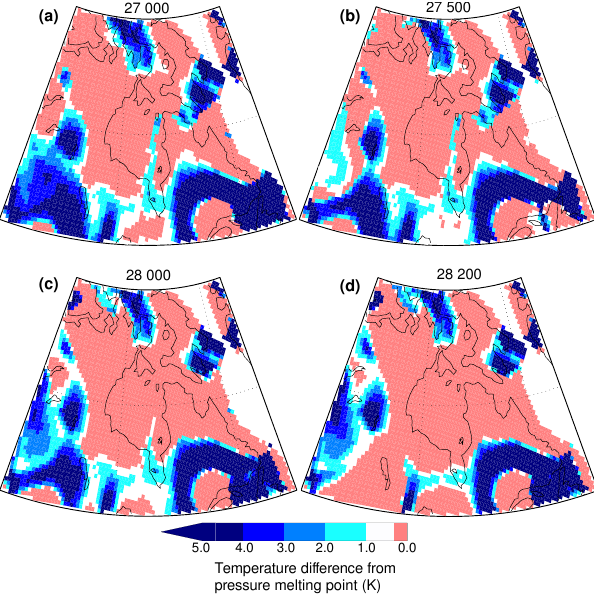
Figure 4. Time slices of the basal temperature field taken at (a) 27000 years, (b) 27500 years, (c) 28000 years and (d) 28200 years. The times shown are the same as those in Fig. 5. Temper- atures are plotted relative to the pressure melting point, with red colours indicating where the ice sheet base is at pressure melting.